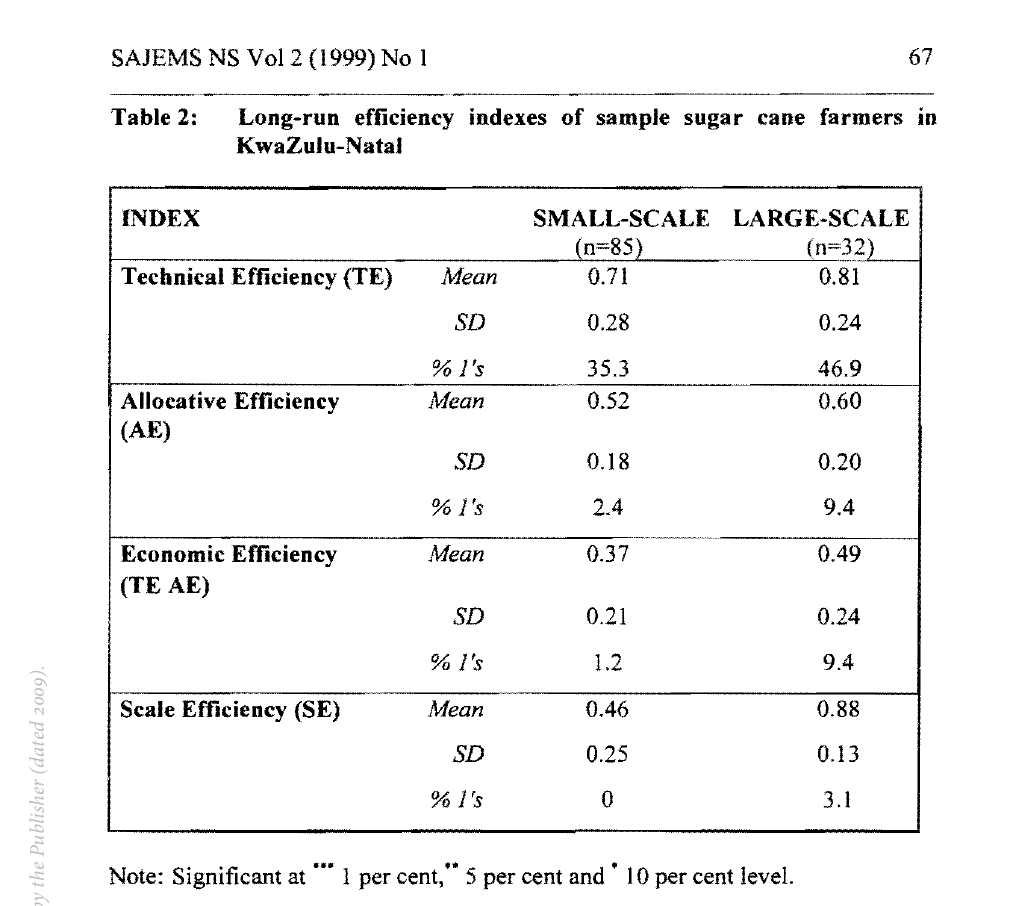
Table 2: Long-run efficiency indexes of sample sugar cane farmers